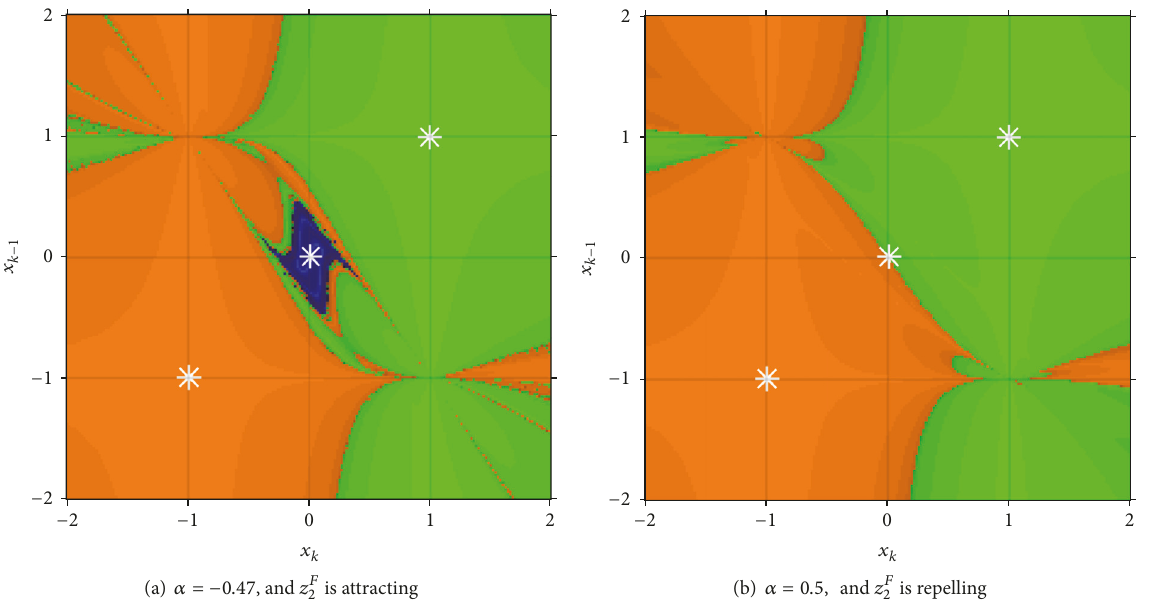
Figure 11: Dynamical planes of method 𝑀 𝛼 (𝑧, 𝑥) for 𝑓(𝑥) = 𝑥 2 − 1